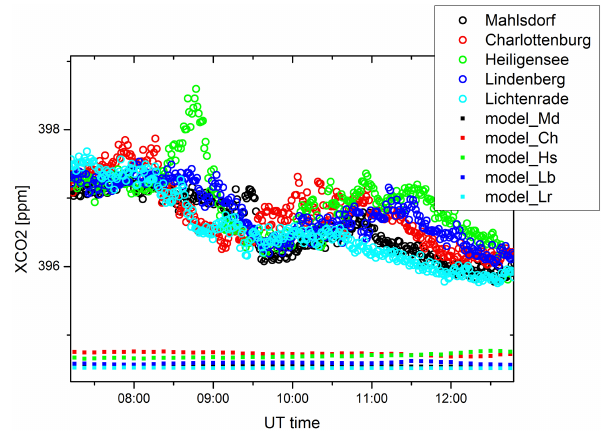
Figure 8. Observed and modelled XCO 2 for 4 July. Due to the high variability of the upstream values observed during this day, no at- tempt has been made to construct a common background value.